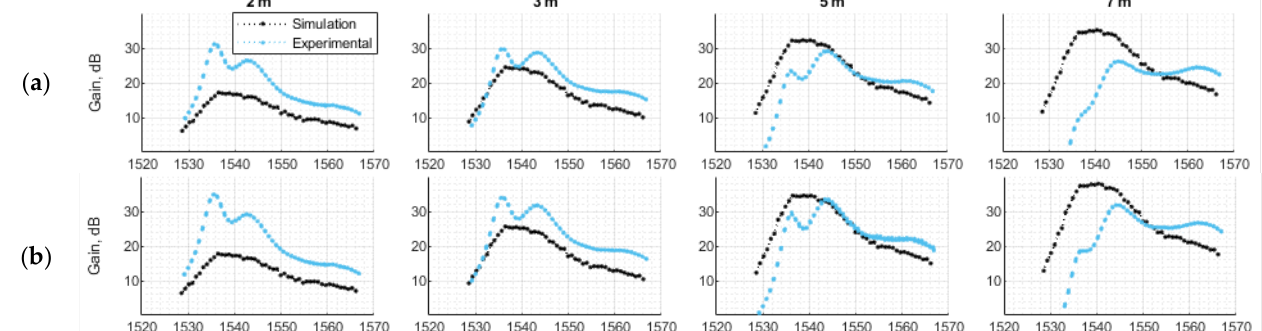
Figure 9. Experimental EYDFA gain measurements overlaid on simulation results at −20 dBm/ch signal power and a pump power of ( a ) 1 W and ( b ) 2 W.